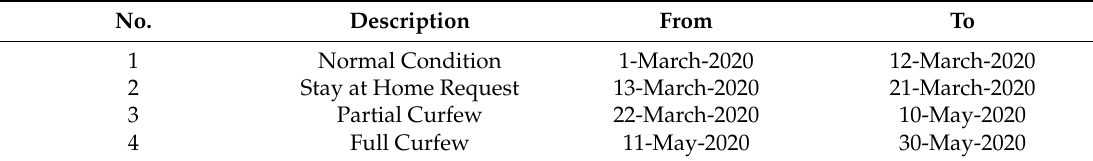
Table 1. Four di ff erent conditions over the test